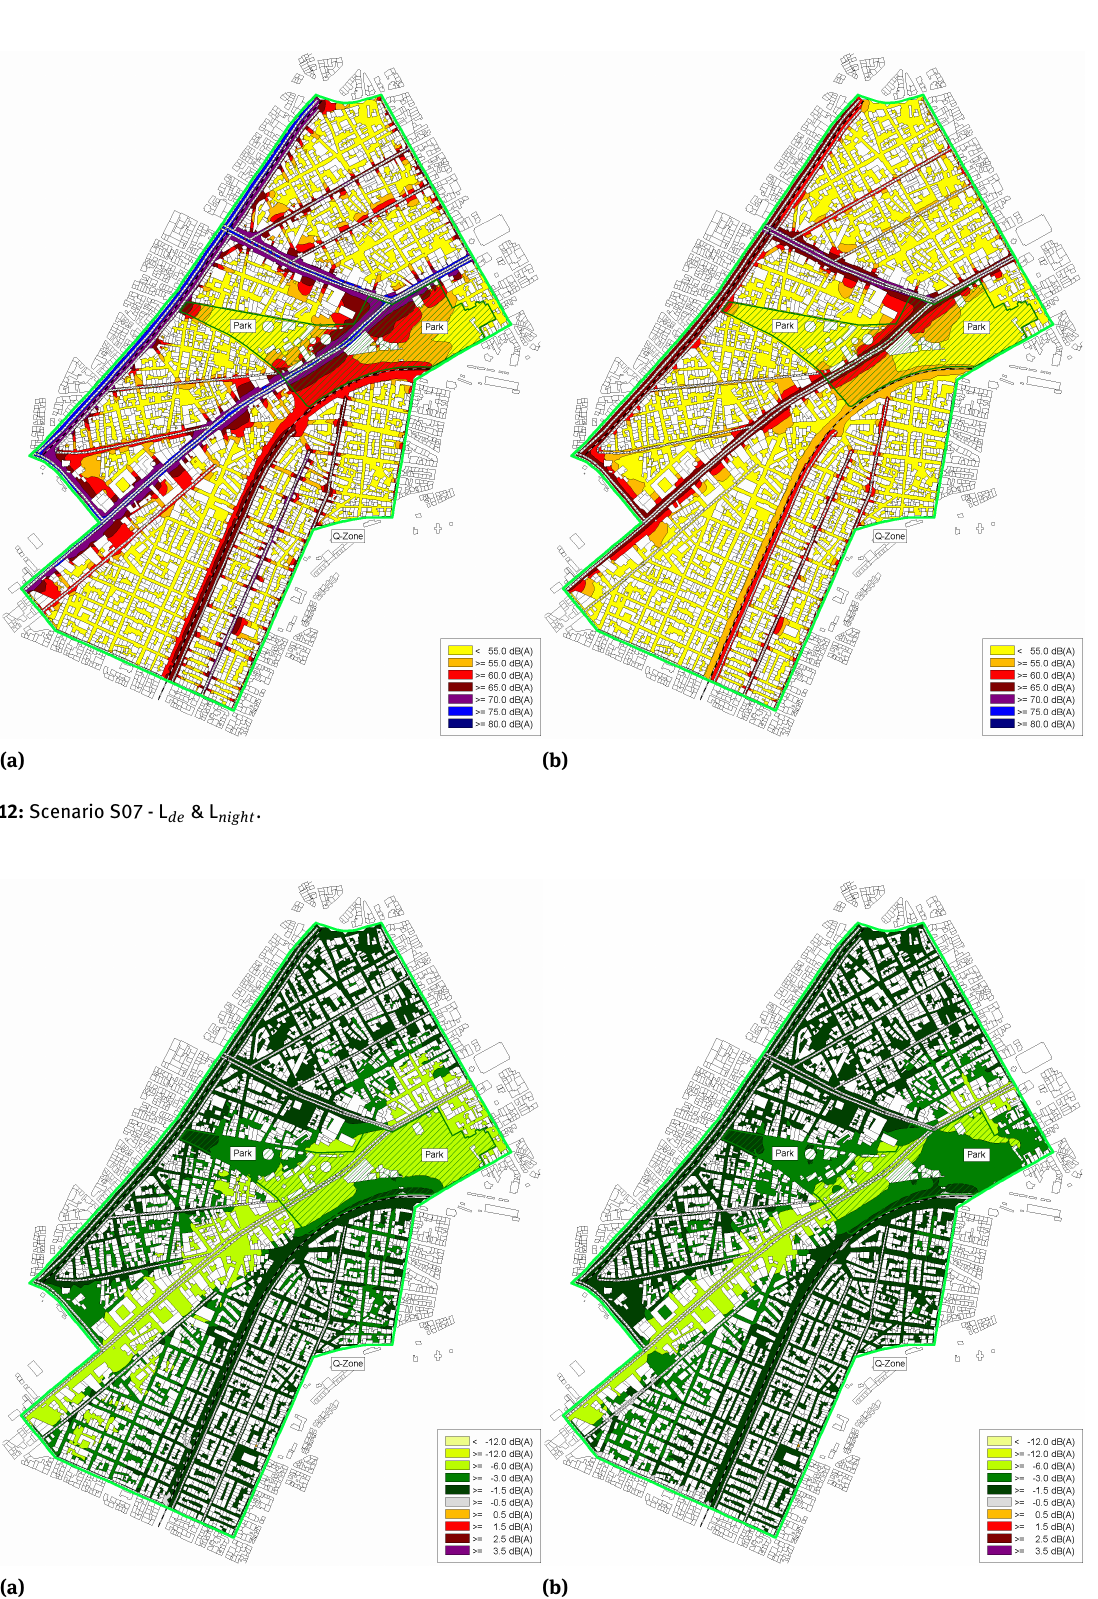
Figure 13: Difference Scenarios S02-S01 - L